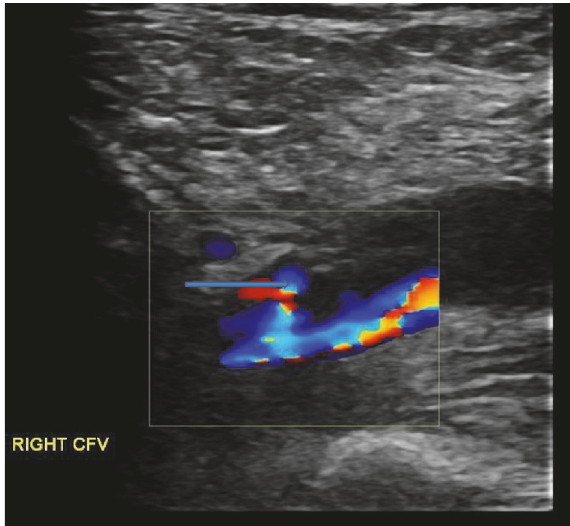
Figure 2: Turbulent flow seen distal to obstruction at right common femoral vein